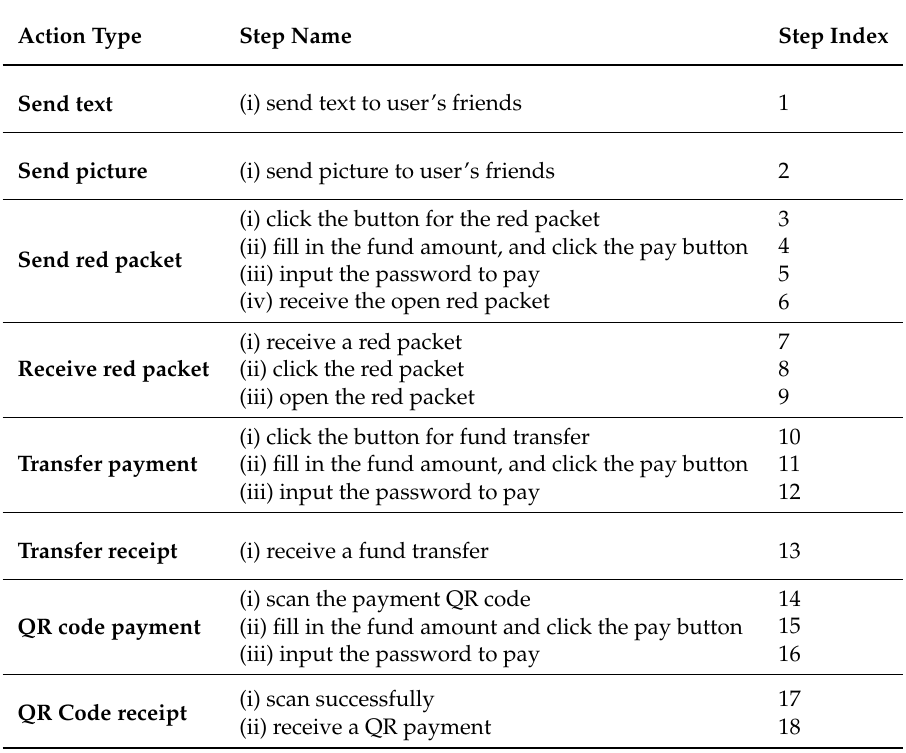
Table 1. Illustration of both user actions and steps within an